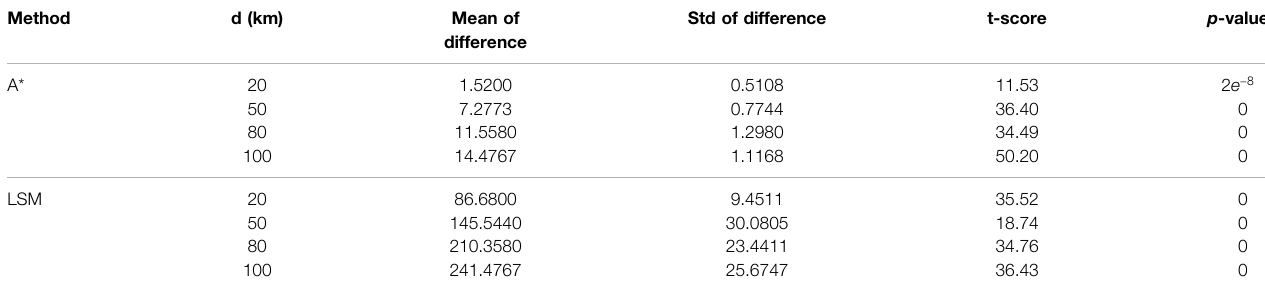
TABLE 3 | Post-hoc analysis of simulation comparison between the proposed method, A*, and LSM. The mean and STD of difference describe the mean and standard deviation of the computation time difference between the proposed method and the two other methods. The signi fi cance level is set as α (cid:2) 0 . 05 when computing the p